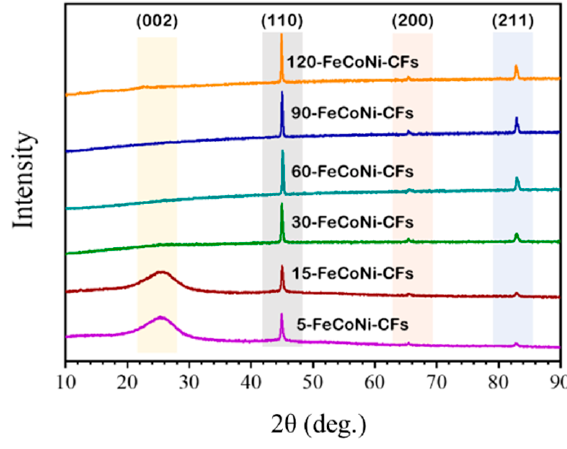
Figure 5. XRD patterns of FeCoNi-CFs as a function of plating time.